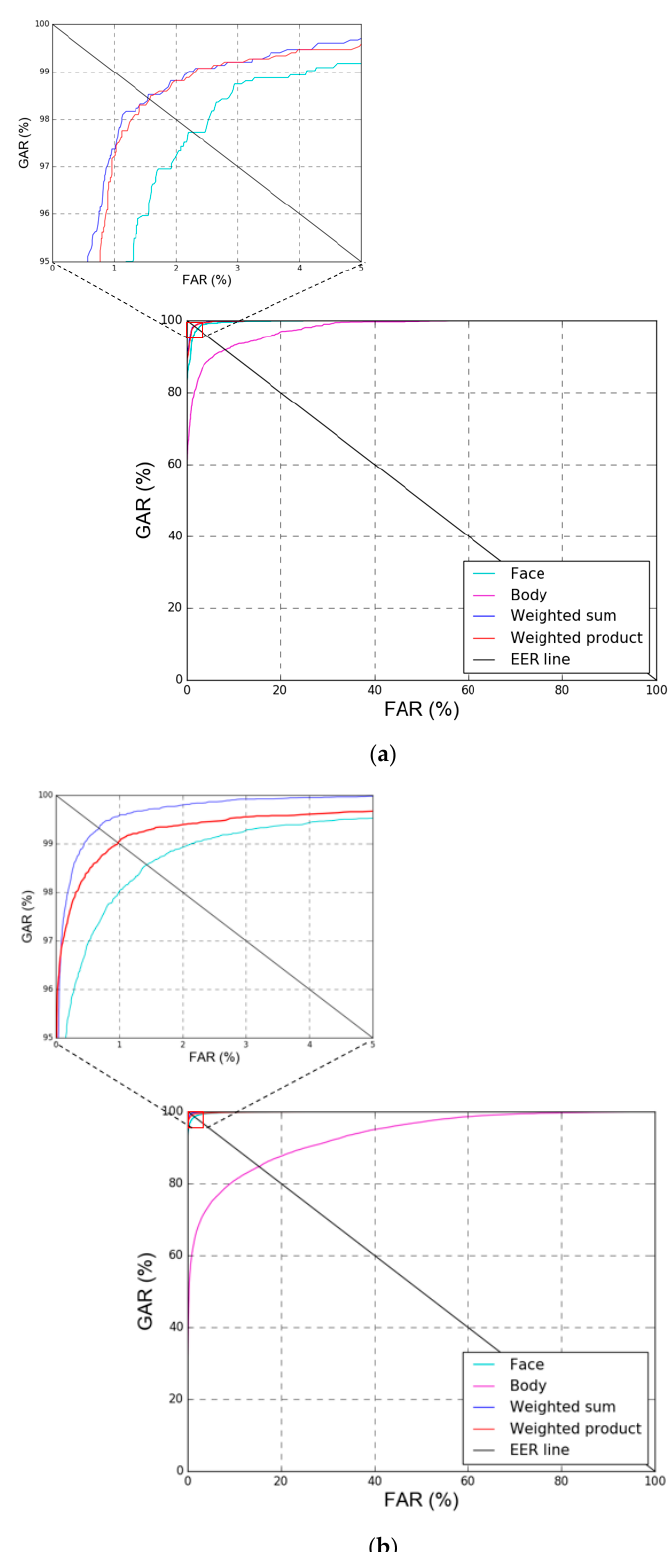
Figure 14. ROC curves by single modality-based method and score-level fusion. With ( a ) DFB-DB1, ( b ) ChokePoint dataset. GAR, FAR, and EER mean genuine acceptance rate, false acceptance rate, and equal error rate, respectively.